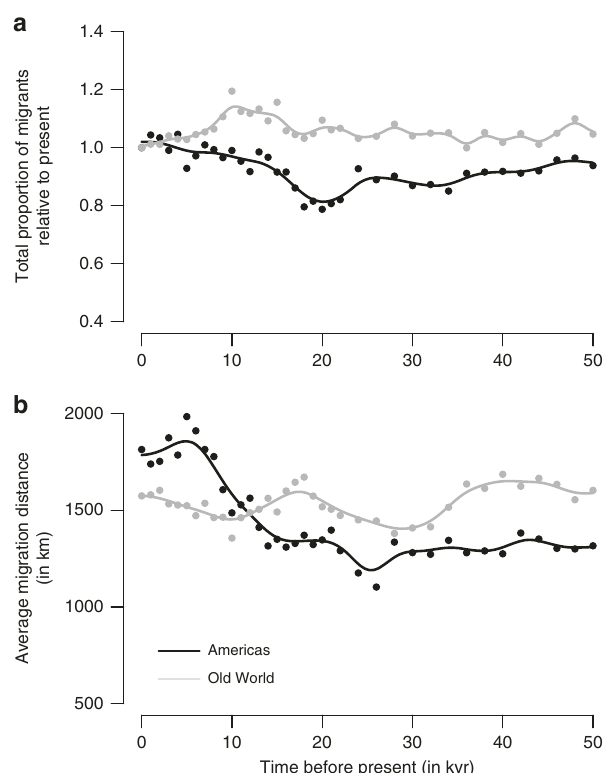
Fig. 3 Predicted proportion of migrants and average migration distance over the last 50,000 years. a Evolution of the total proportion of simulated bird species that are migrants across the world relative to the present value. b Evolution of the average distance between breeding and non-breeding grounds for migrant species, computed as the great circle distance between the centroids of the seasonal ranges. These simulated time series are shown for the Americas (in black) and the Old World (in